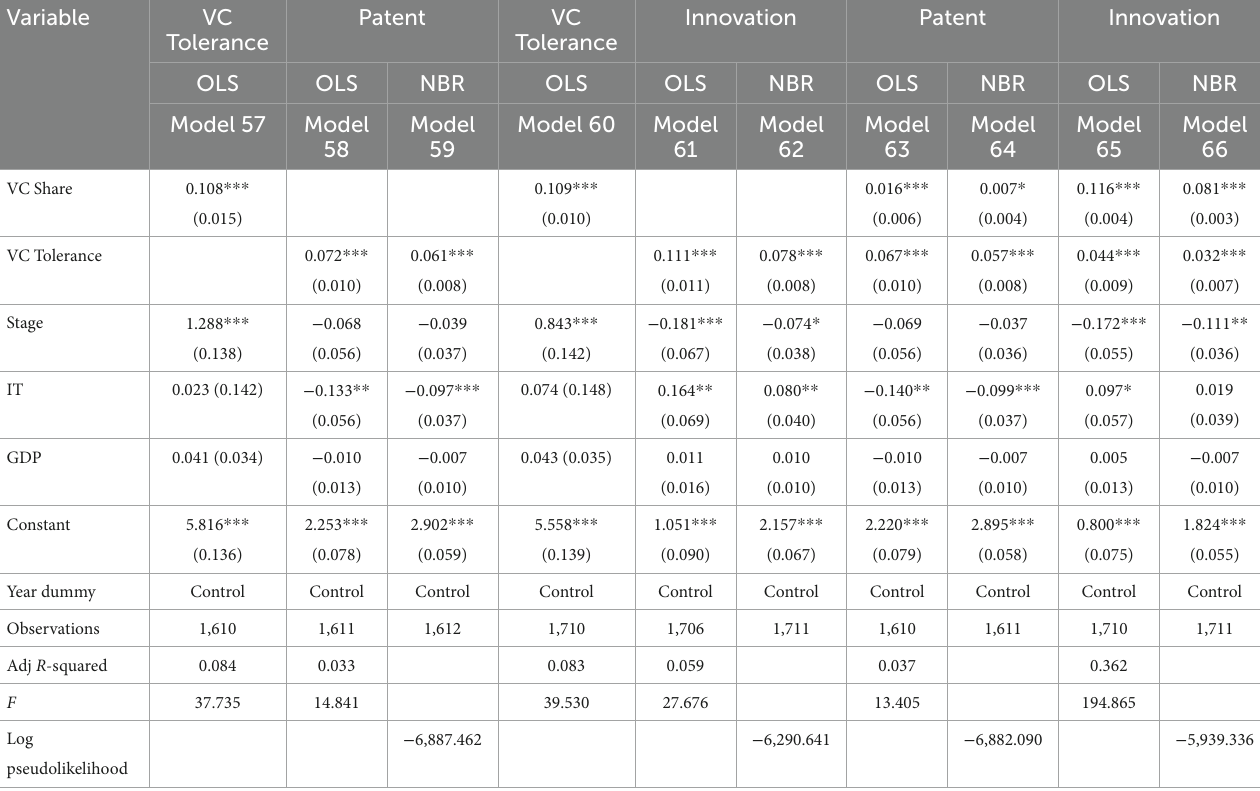
TABLE 12 Impact of venture capital shareholding and failure tolerance on enterprise innovation performance.